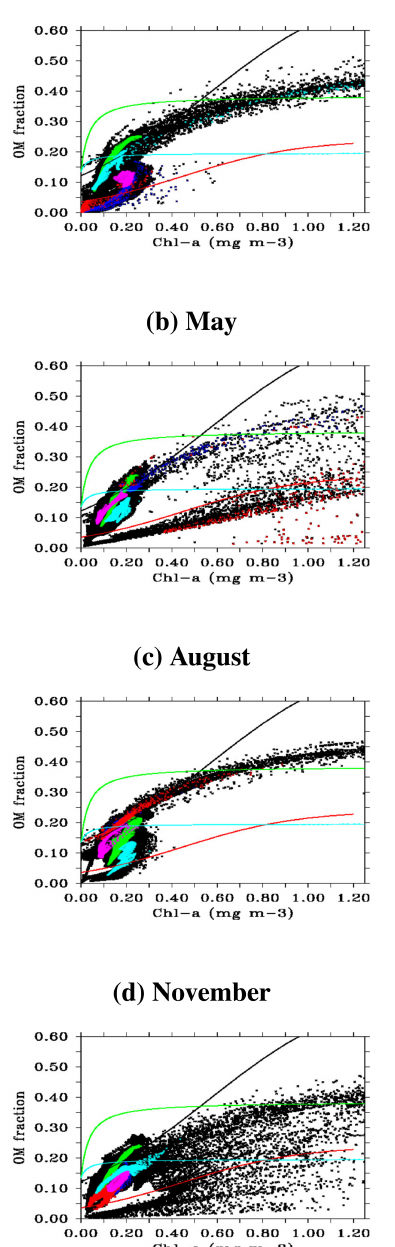
Figure 10. POP-simulated chl a vs. submicron SSA dry organic mass fraction, with model output from five geographic regions highlighted (BASE case). Colored points are data in the regions shaded in corresponding colors in Fig. 9, i.e., red: Arctic; dark blue: North Atlantic; magenta: Northeast Pacific; green: South- east Pacific; cyan: Southern Ocean. Black points indicate rest of world. Black and red lines indicate empirical fits to observations from Mace Head, Ireland ( D p < 1 . 5µm), and Point Reyes, Califor- nia ( D p < 2 . 5µm), respectively (Gantt et al., 2011). Blue and green lines show the parameterization of Long et al. (2011) for particle diameters of 0.8 and 0.5µm, respectively.